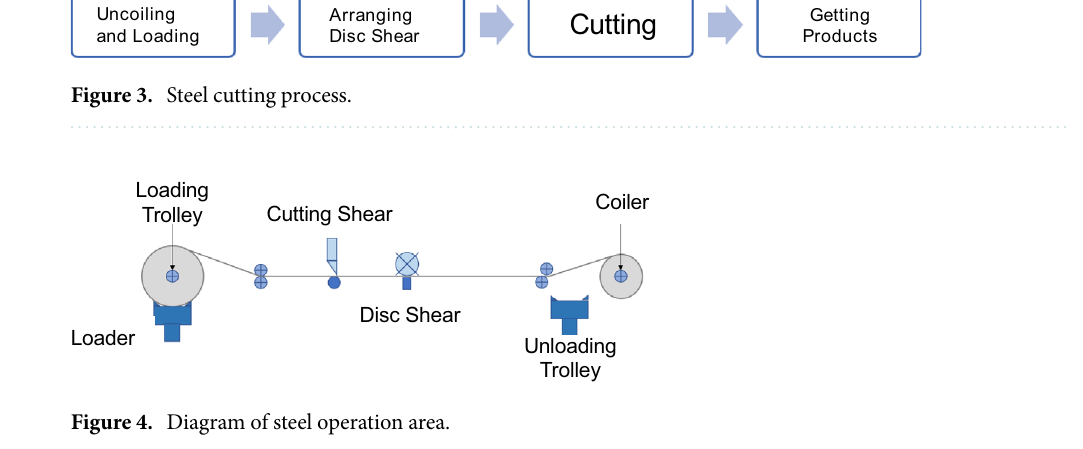
Figure 4. Diagram of steel operation area.